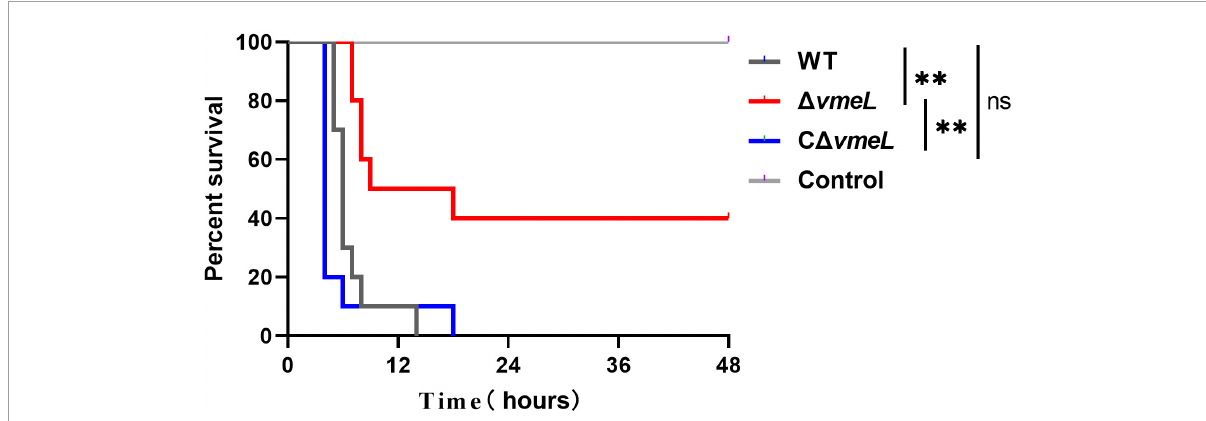
FIGURE5 Institute of Cancer Research female mice (n = 10) were infected through intraperitoneal injection with WT, (cid:49) vmeL , or C (cid:49) vmeL strains of Vibrio parahaemolyticus . Mouse mortality was recorded at the times indicated. WT, wild-type; (cid:49) vmeL , vmeL deletion mutant; C (cid:49) vmeL , deletion mutant complemented strain. ** indicates statistical significance at P <